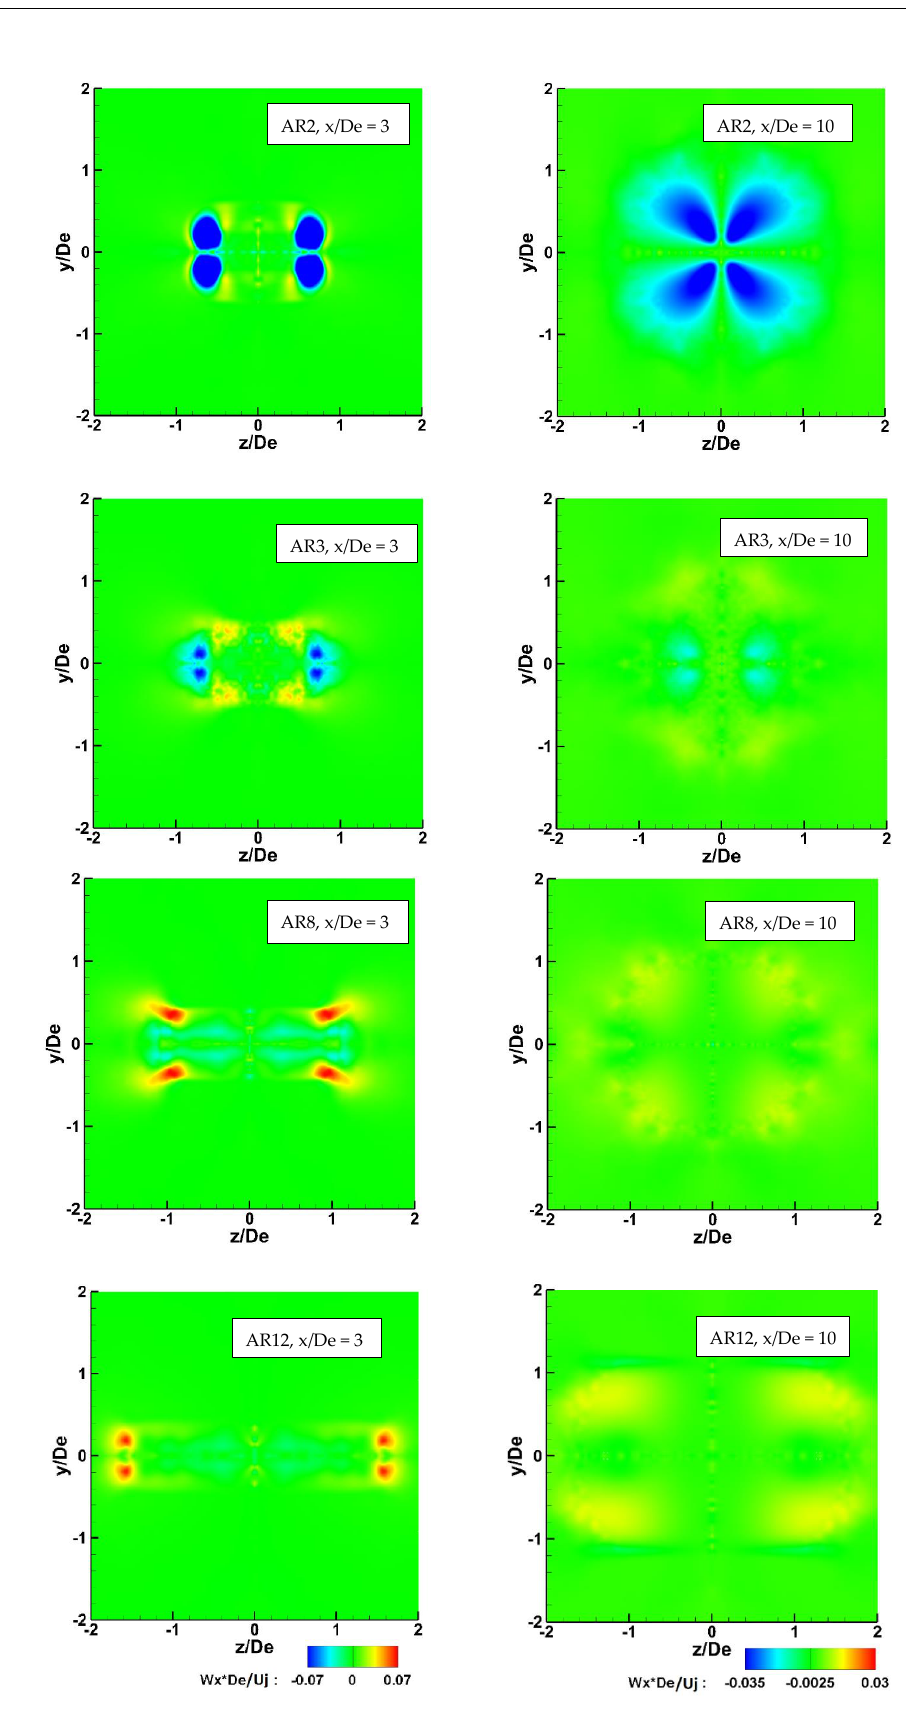
Figure 13 . Normalized streamwise vorticity contours at x/De = 3 ( left ), x/De = 10 ( right )—AR = 2, 3, 8, 12 from top to bottom.